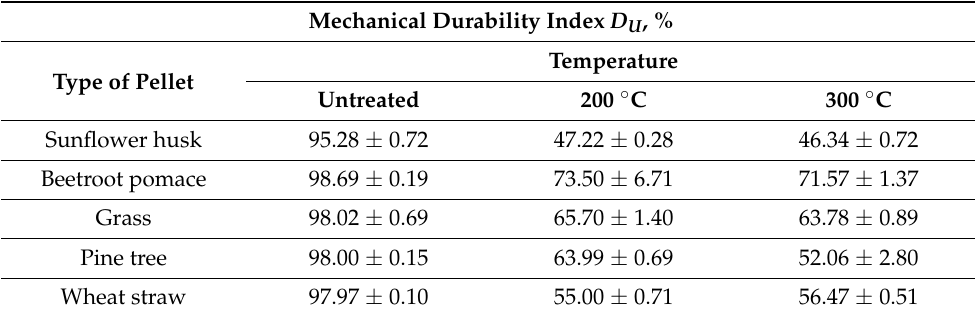
Table 1. Mean mechanical durability index D U of raw and torrefied pellets from biomass after the tests performed according to PN-EN ISO 17831-1:2016-02